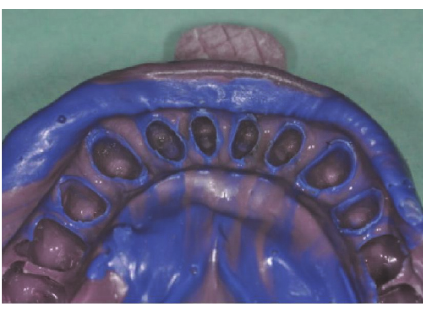
Figure 14: Conditioned soft tissue.